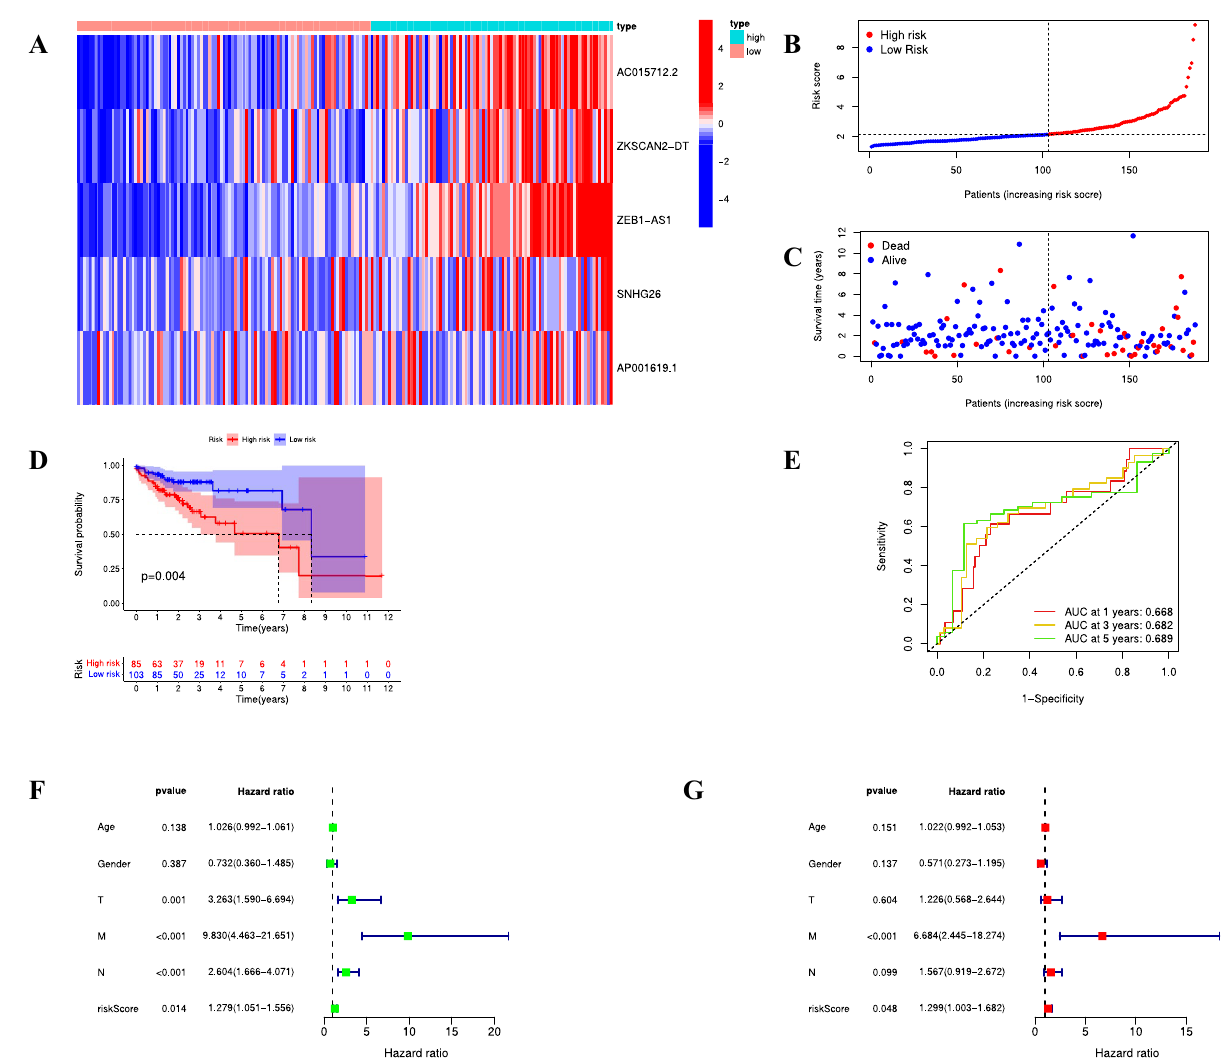
Figure 7. Verification of prognostic CRL signature. ( A ) Expression of five CRLs between high- and low-risk groups in the validation cohort. ( B , C ) Distribution of risk score and survival states for all COAD patients in the validation cohort. ( D ) Kaplan–Meier curves of OS based on the risk score in the validation cohort. ( E ) Receiver operating characteristic (ROC) curve analysis in the validation cohort. ( F , G ) Univariate Cox regression analysis ( F ) and multivariate Cox regression analysis ( G ) in the validation